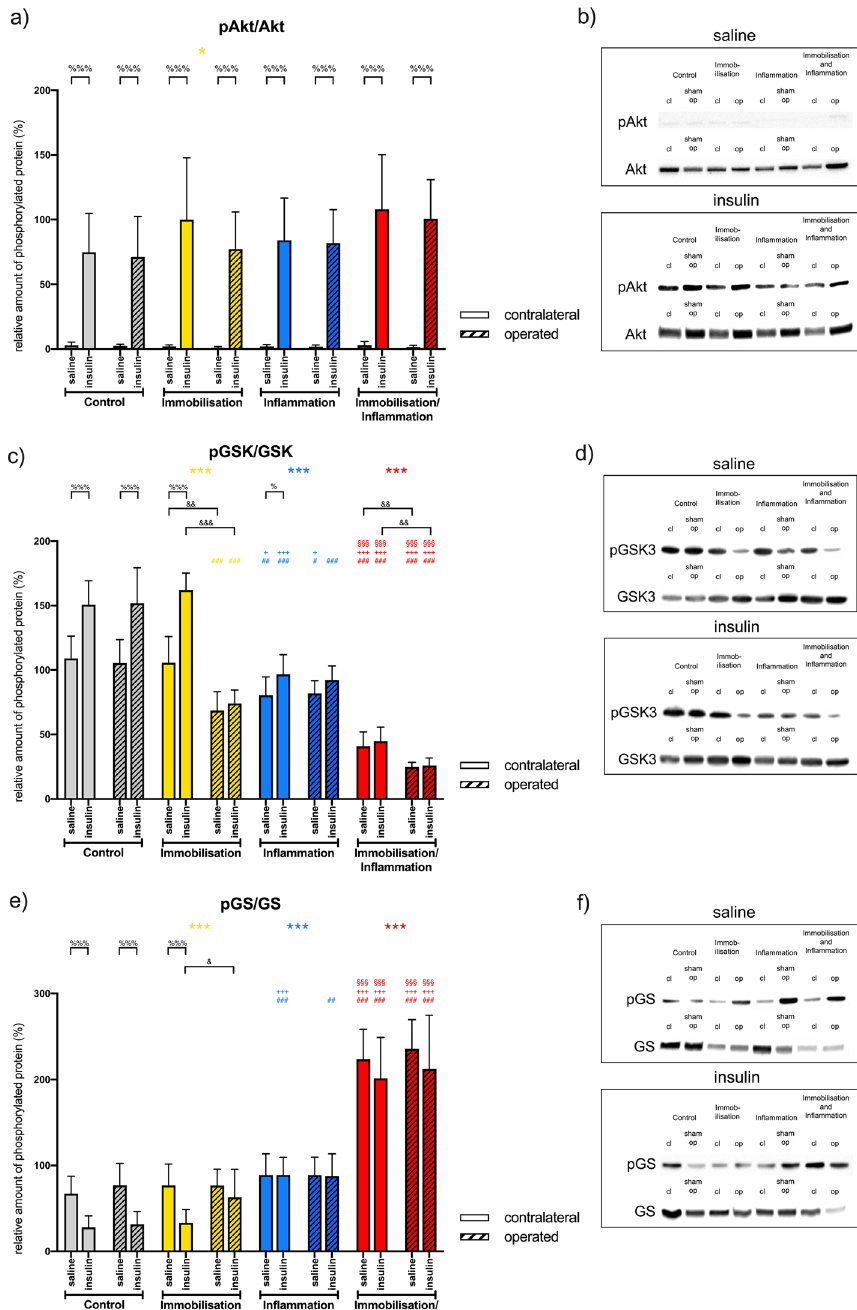
Fig. 5 Relative amount as well as western blots of phosphorylated key enzymes of the insulin signaling pathway. The number of identical symbols at top of each box indicate the significance level: one < 0.05; two < 0.01 and three < 0.001. Expression values were normalised to total protein. Protein kinase b Akt; = phosphorylated Protein kinase B pAkt; glycogen synthase kinase 3 beta (GSK3); phosphorylated glycogen = synthase kinase 3 beta (pGSK3); Glycogen synthase GS; phosphorylated Glycogen synthase (pGS); = contralateral cl; operated op; sham-operated sham op. *Significant the main effect of the factors = = = immobilisation, inflammation as well as immobilisation and inflammation. # Significant difference to the control group for the respective leg. + Significant difference to the immobilisation group for the respective leg. § Significant difference to the inflammation group for the respective leg. % Significant difference of the insulin group to the saline group for the respective group. & Significant difference of the operated leg to the contralateral leg for the respective